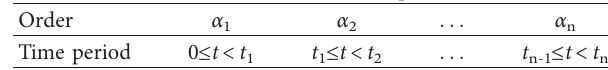
Table 2: Value α ( t ) versus creep time [137].